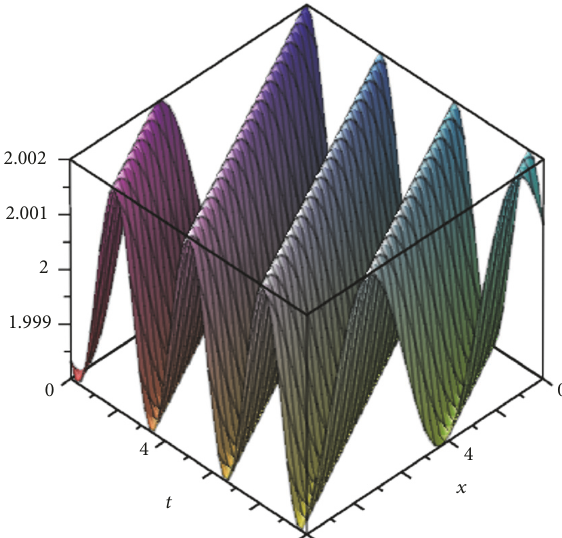
Figure 1: 3D plot of (46) with 𝑎 0 = 1.9 , 𝑎 1 = 1.7 , 𝑎 2 = 0.77 , 𝛾 = 1 , 𝛼 = 0.8 , 𝛽 = 2.